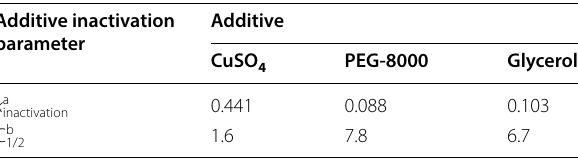
Table 4 The effect of selected additives used in the reaction mixture on laccase activity of an enzymatic extract, obtained from Coriolus hirsutus in aqueous medium composed of acetate buffer (0.1 M, pH 5.0), using syringaldazine as substrate